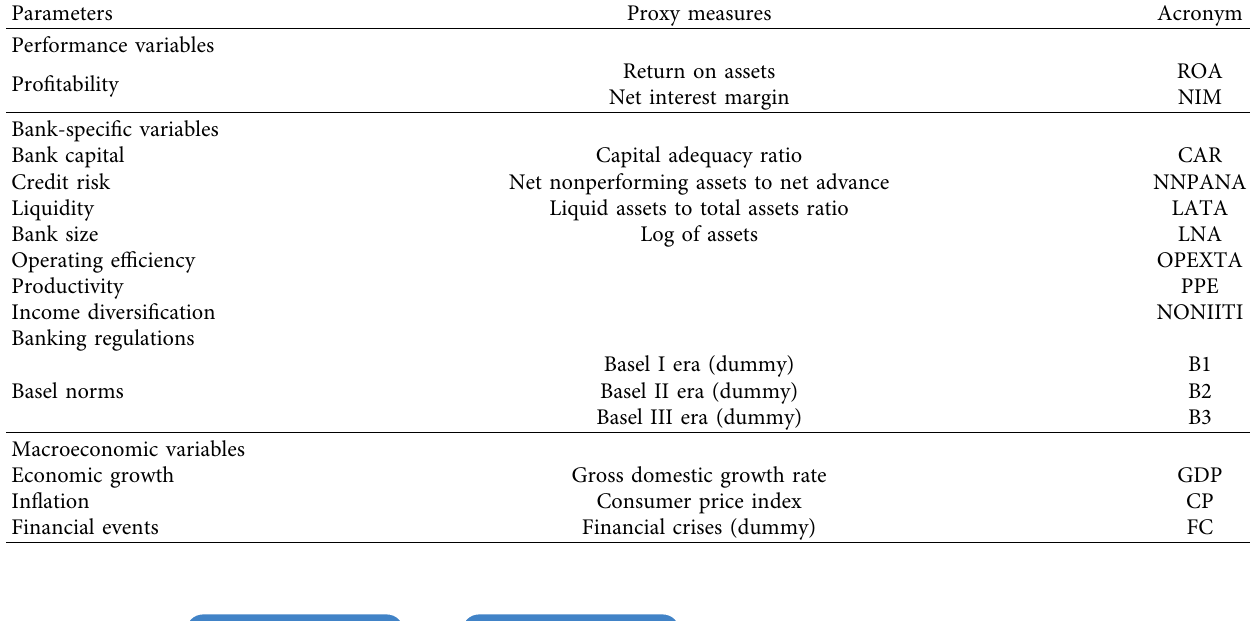
Table 1: Description of variables of the